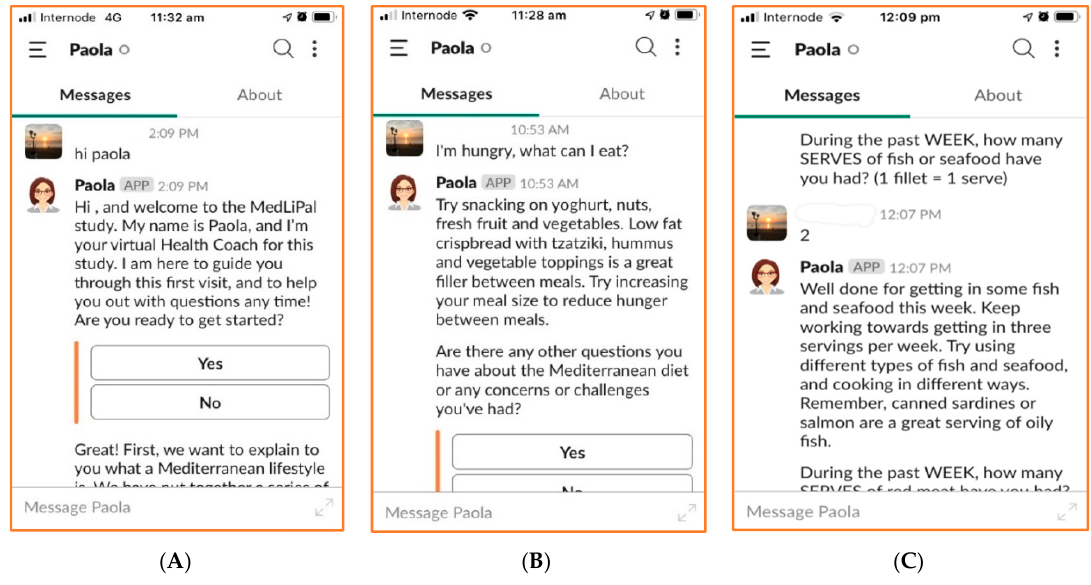
Figure 1. Screenshots of interactions with Paola via Slack application. Panel ( A ): The beginning of the baseline initiation. Panel ( B ): Paola responding to a question. Panel ( C ): Weekly check-in process.